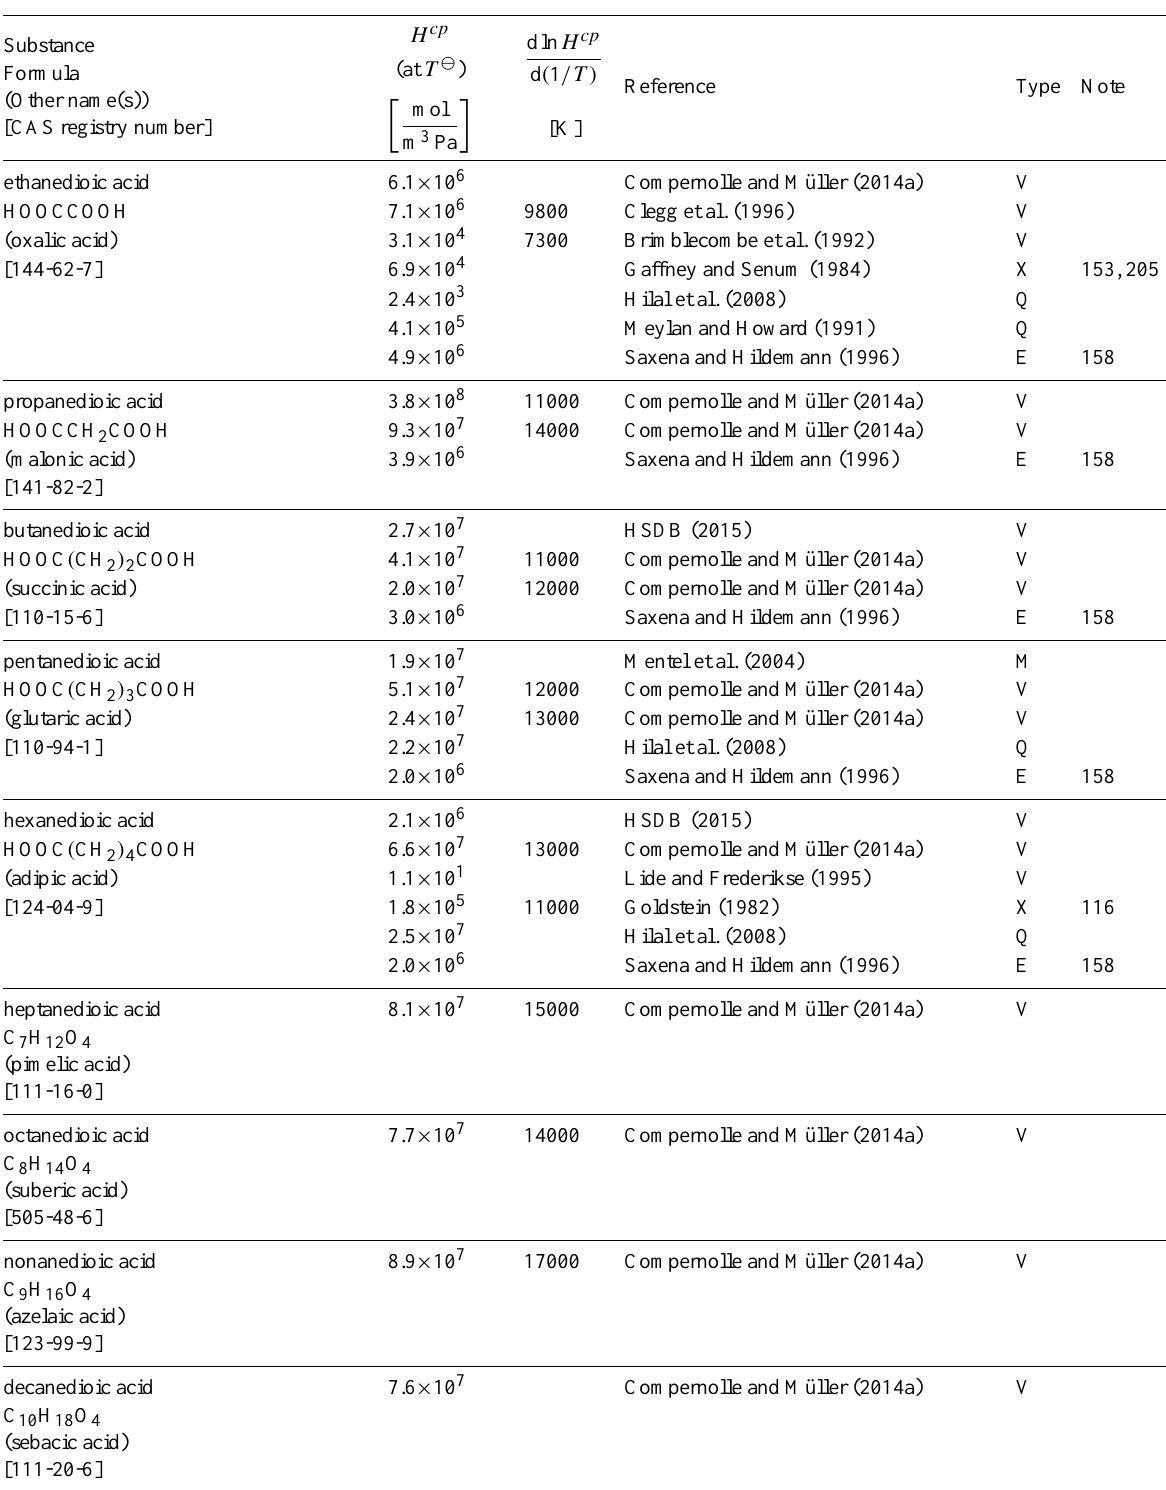
Table 6: Henry’s law constants for water as solvent